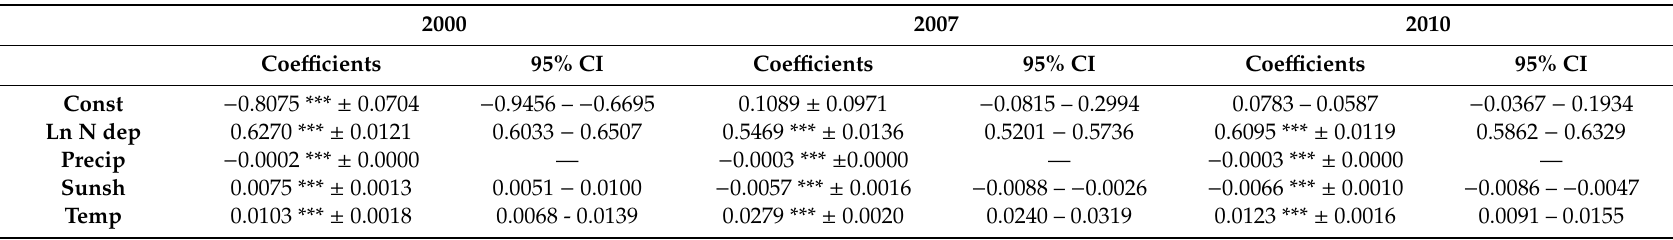
Table 7. Regression coe ffi cients with heteroscedasticity-consistent standard errors for grasslands. Const: Constant, Ln N dep: Natural logarithm of N deposition, Temp: Temperature, Precip: Precipitation, and Sunsh: Sunshine. *** Statistically significant p < 0.001.